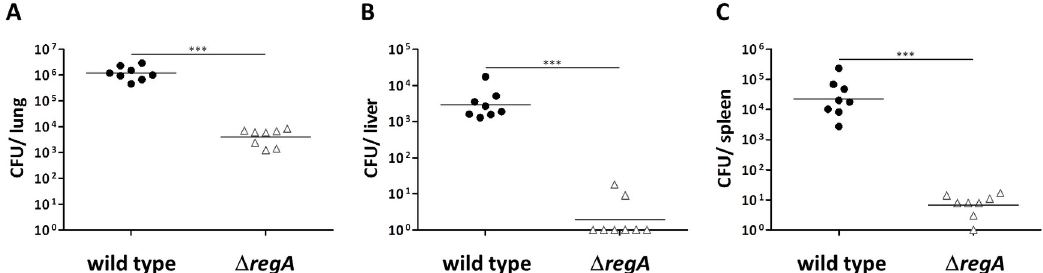
Fig 4. Determination of bacterial loads in lung (A), liver (B), and spleen (C) 48 h after i.n. infection of mice (n = 8) with * 100 CFU B . pseudomallei wild type or Δ regA mutant. Shown are pooled data of two independent experiments. Significant differences were calculated using Student’s t test with Welch´s correction.( ��� p <